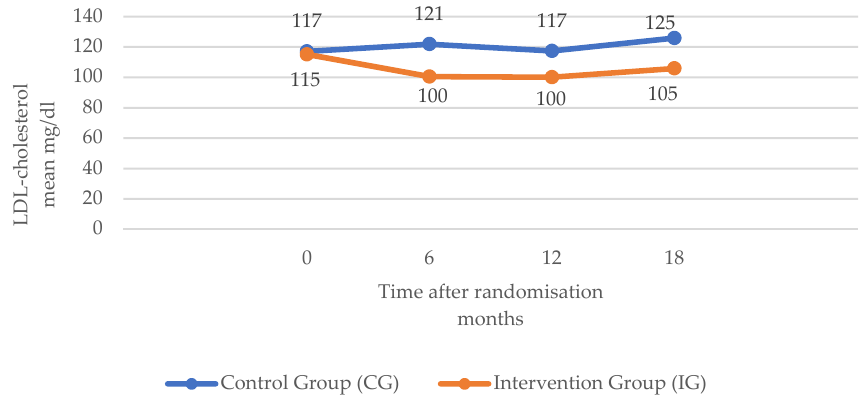
Figure 3. Evolution of (LDL) cholesterol in the two groups in the RCT study.